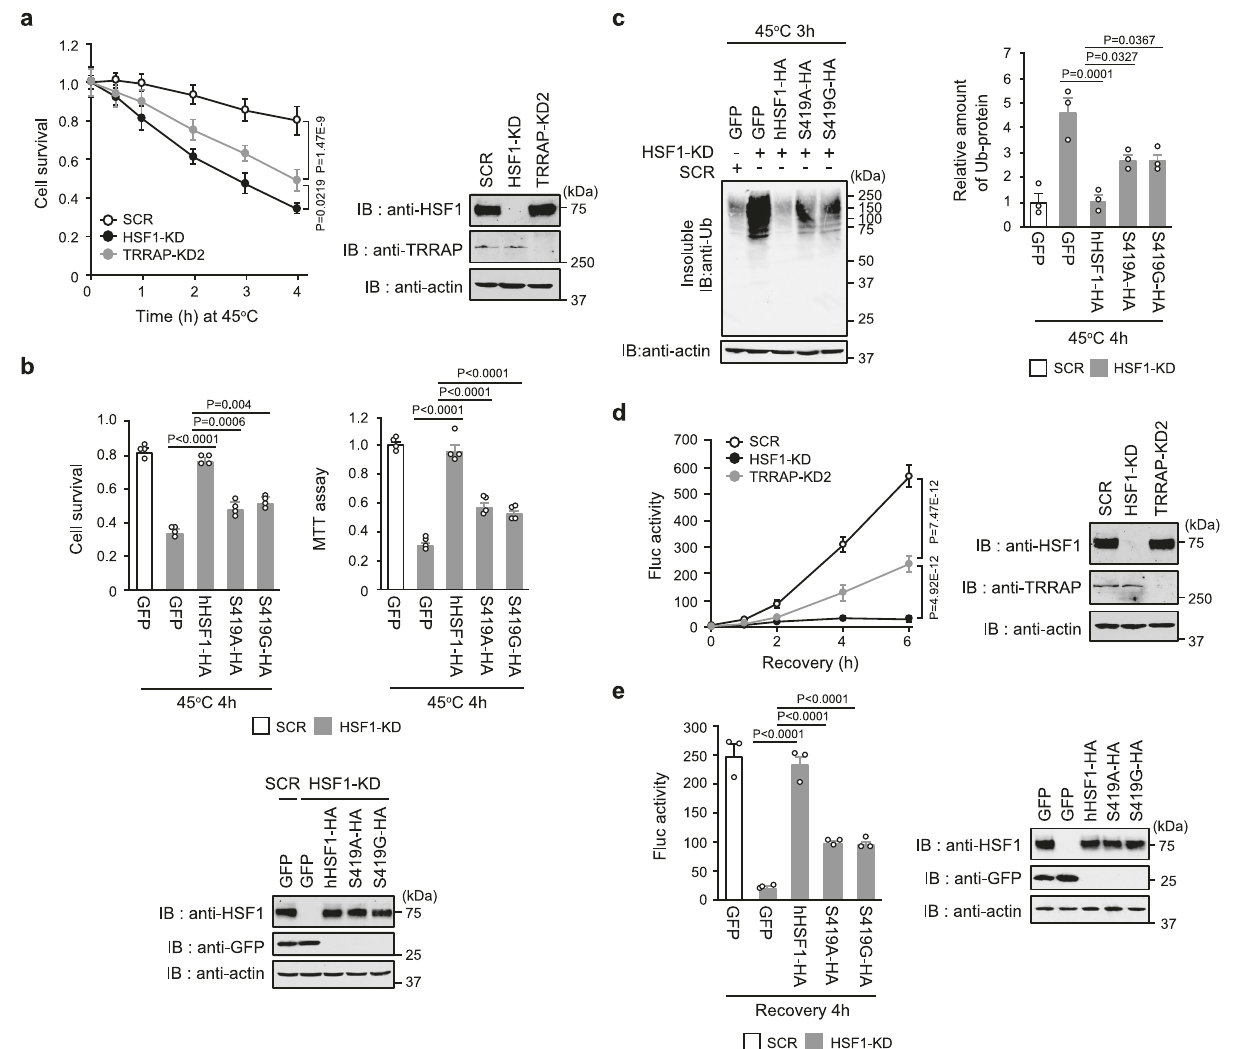
promotes refolding of the luciferase sensor protein during recovery from heat shock.HeLa-Fluccellstreatedasdescribedin a wereheat-shockedat42°Cfor2h. These cells werethen recovered at 37°C for the indicated periods,and luciferase activity values were calculated and normalized to the value of control cells (100%).Extractsofcellsweresubjectedtoimmunoblotting. e Phosphorylationof HSF1-S419 promotes refolding of the luciferase sensor protein. HeLa-Fluc cells treatedasdescribedin b wereheat-shockedat42°Cfor2h.Thesecellswerethen recovered at37°Cfor4h,and luciferase activityvalues relative to thatof control cells were estimated. Extracts of cells were subjected to immunoblotting. Norminal p values were determined by two-way ANOVA in a and d or by one-way ANOVA, followed by Tukey-Kramer test in b , c and e . Error bars indicate SEM ( n =4) in a and b , or ( n =3) in c , d , and e